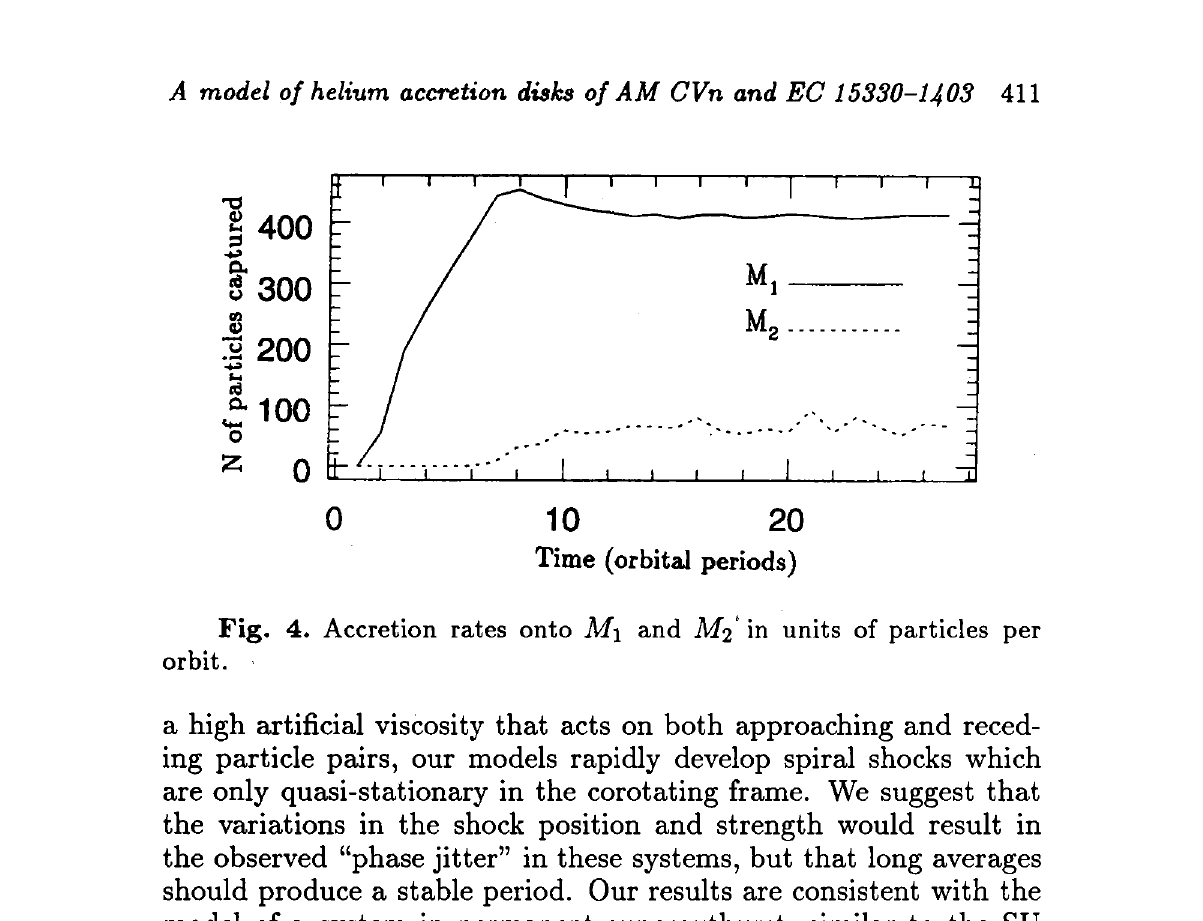
Fig. 4. Accretion rates onto M\ and M2 in units of particles per